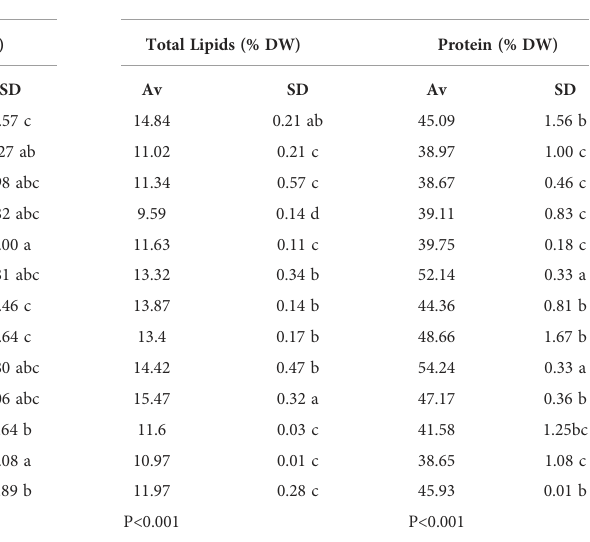
TABLE 5 Protein and lipid content (% dry weight. DW) of the muscle and liver of rainbow trout fed the experimental diets.